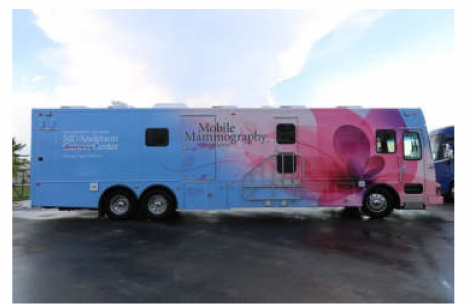
Figure 1. A mobile mammography van.